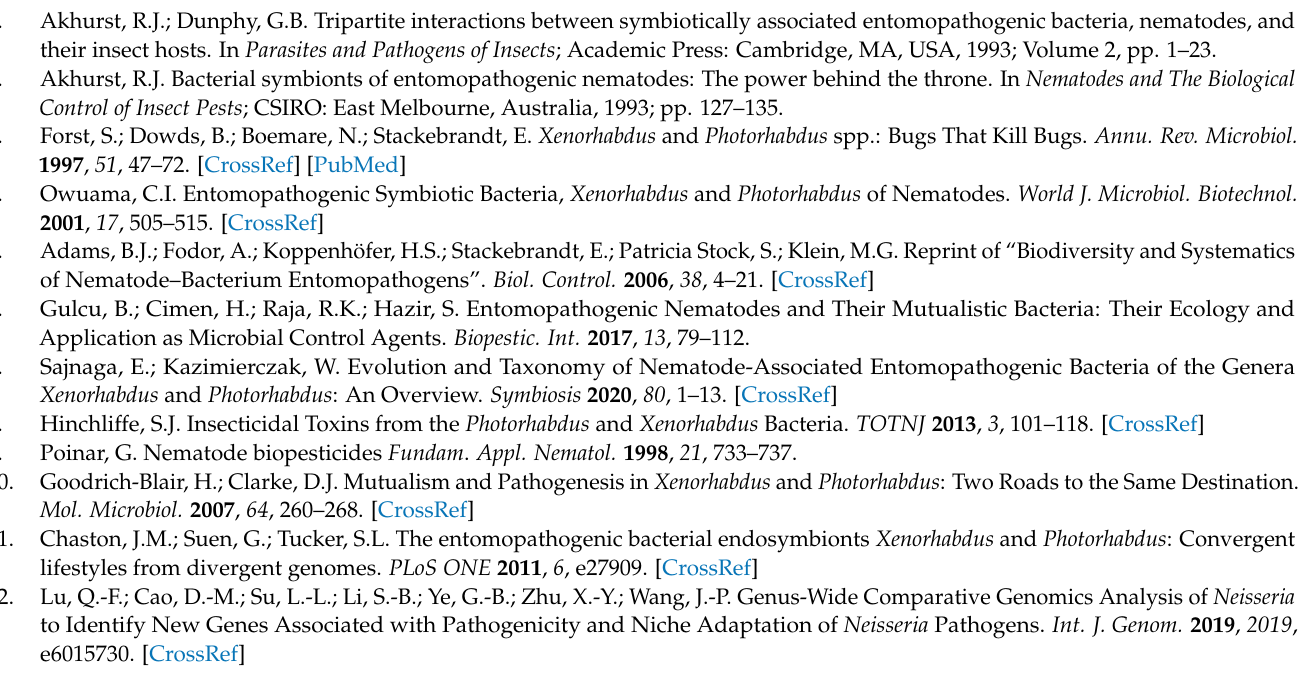
Table S2: Genus-specific genes of Xenorhabdus and Photorhabdus; Figure S1: Phenotypes of G.mellonella larvae after injection X.nematophila SC 0516; Figure S2: SDS-PAGE of purified GroEL proteins from X. nematophila SC 0516 (Cpn60-Xn) and P. luminescens HIM3 (Cpn60-Pl); Figure S3: Global alignment of the Cpn60-Xn and Cpn60-Pl